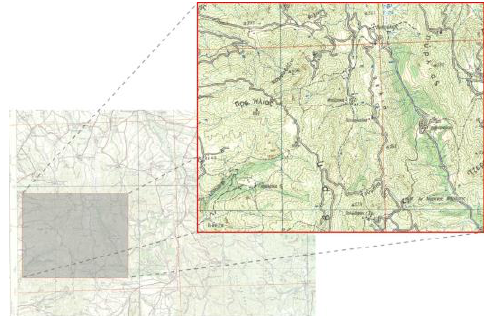
The main cartographic background used for the experimental design is a part of a real topographic